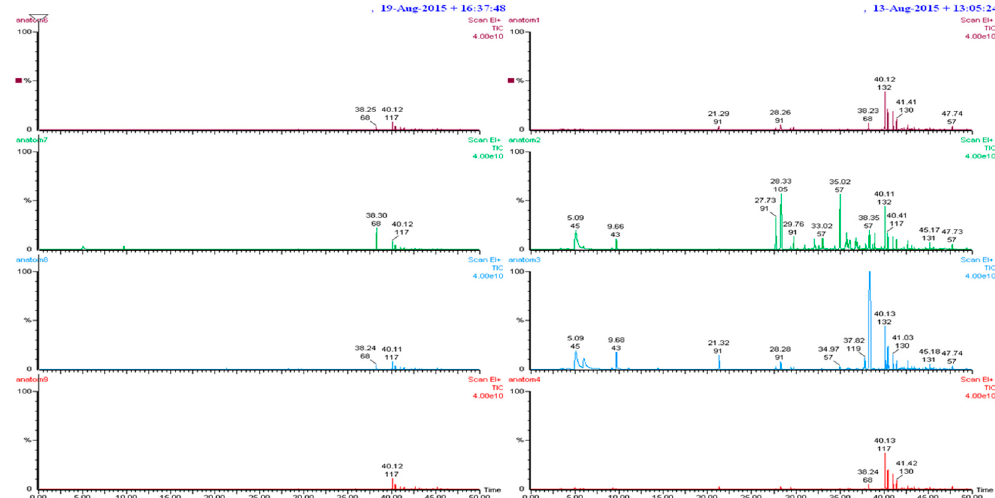
Figure 1. Chromatograms of VOCs measured in the “histology rooms” of anatomical pathology wards A ( right ) and B ( left ). The numbers above each peak indicate, from top to bottom, elution time and ion ( m/z ). Some peaks are deformed by the high amounts present.